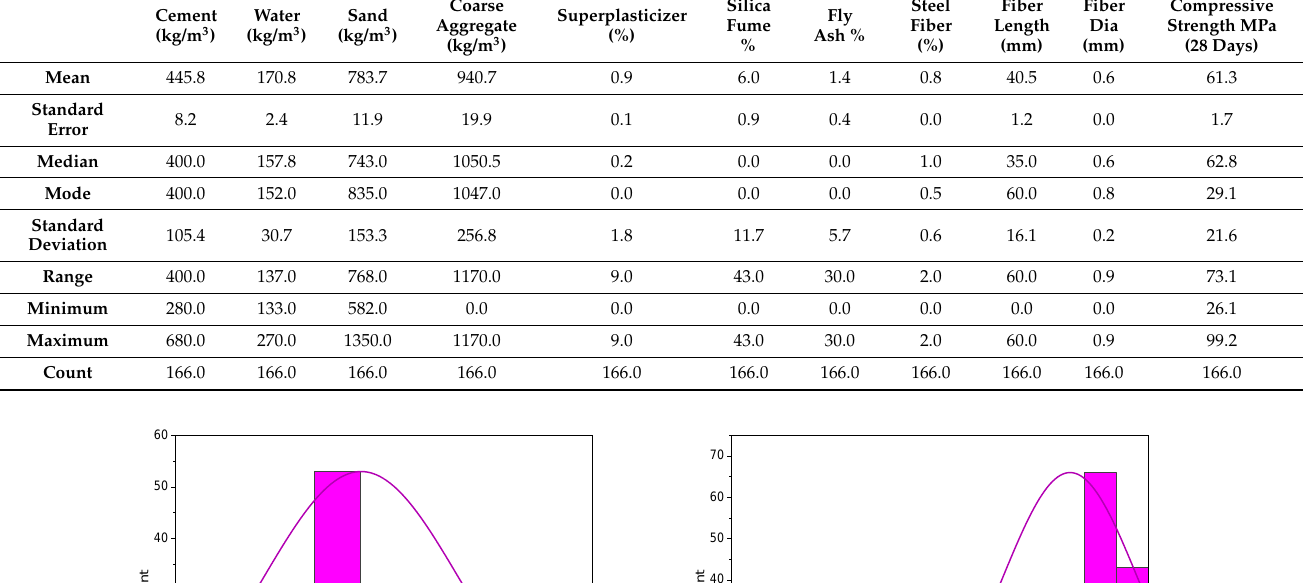
Table 1. Statistical analysis of input and output variables.